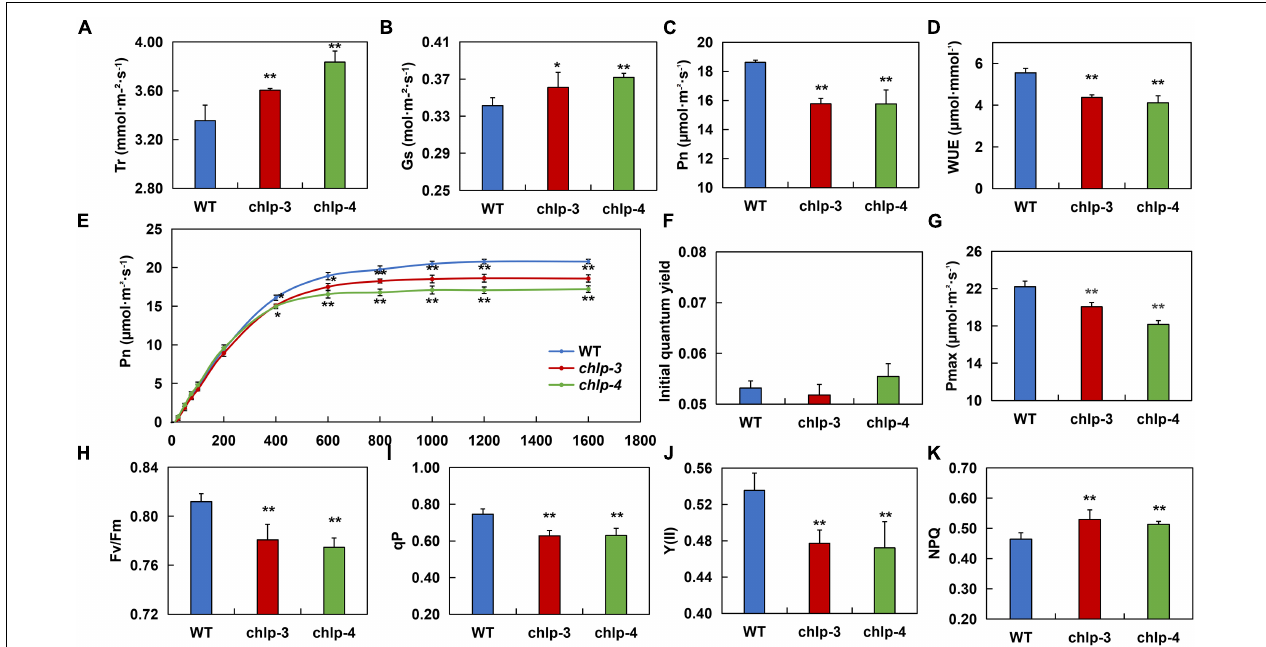
FIGURE 6 | PtrCHLP3 actively regulates photosynthesis. (A–D) The photosynthetic parameters of chlp plants relative to those of WT plants. Tr, transpiration rate; Gs, stomatal conductance; Pn, net photosynthetic rate; WUE, instantaneous water-use efficiency; (E–G) Pn–light curve, initial quantum yield, and Pmax were measured in WT and chlp plants. (H–K) The value [Fv/Fm, Y (II), qP, and NPQ] of the slow dynamic fluorescence induction curve were measured in chlp and WT plants. The value represents the mean ± standard deviation ( n = 40). Asterisks indicate a significant difference at the same level: * indicates P < 0.05; ** indicates P < 0.01,